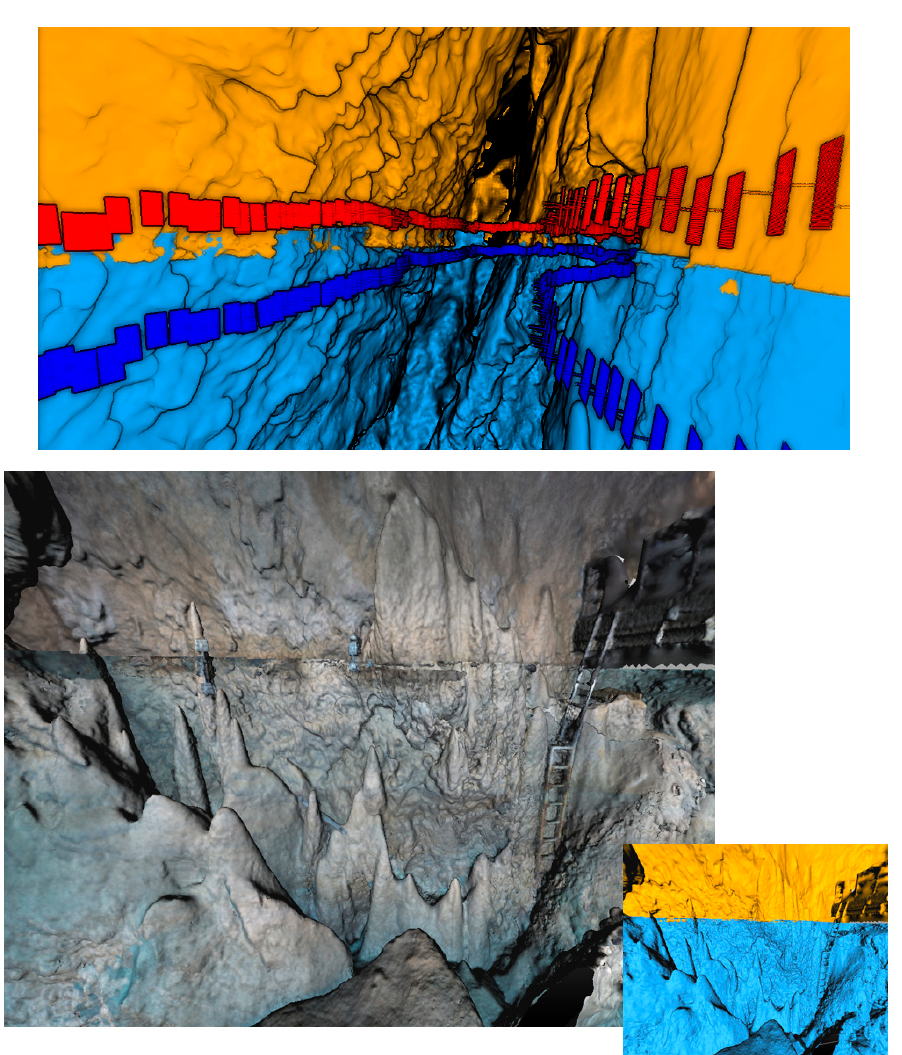
Figure 20. 3D visualization of the surveyed semi submerged chamber with the two parts colored with